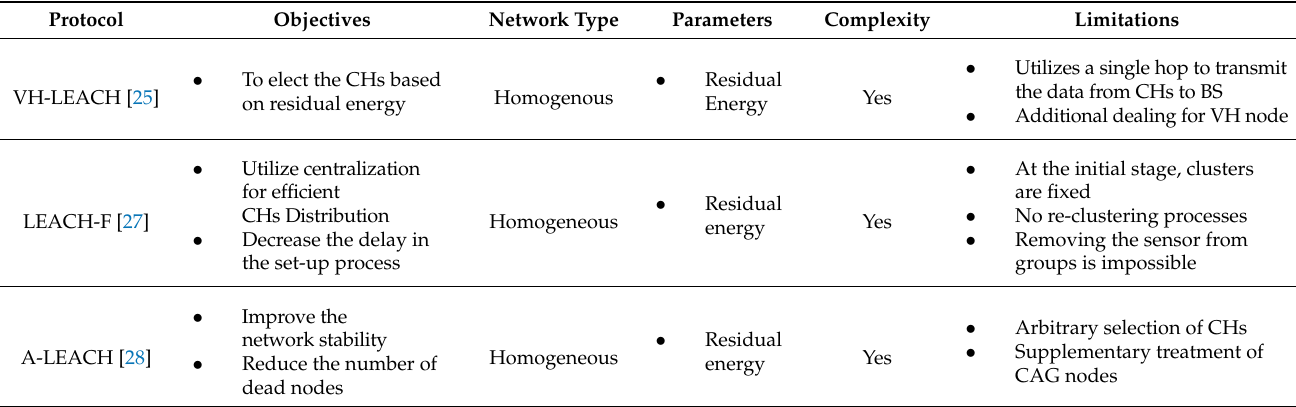
Table 1. General Characteristics of LEACH